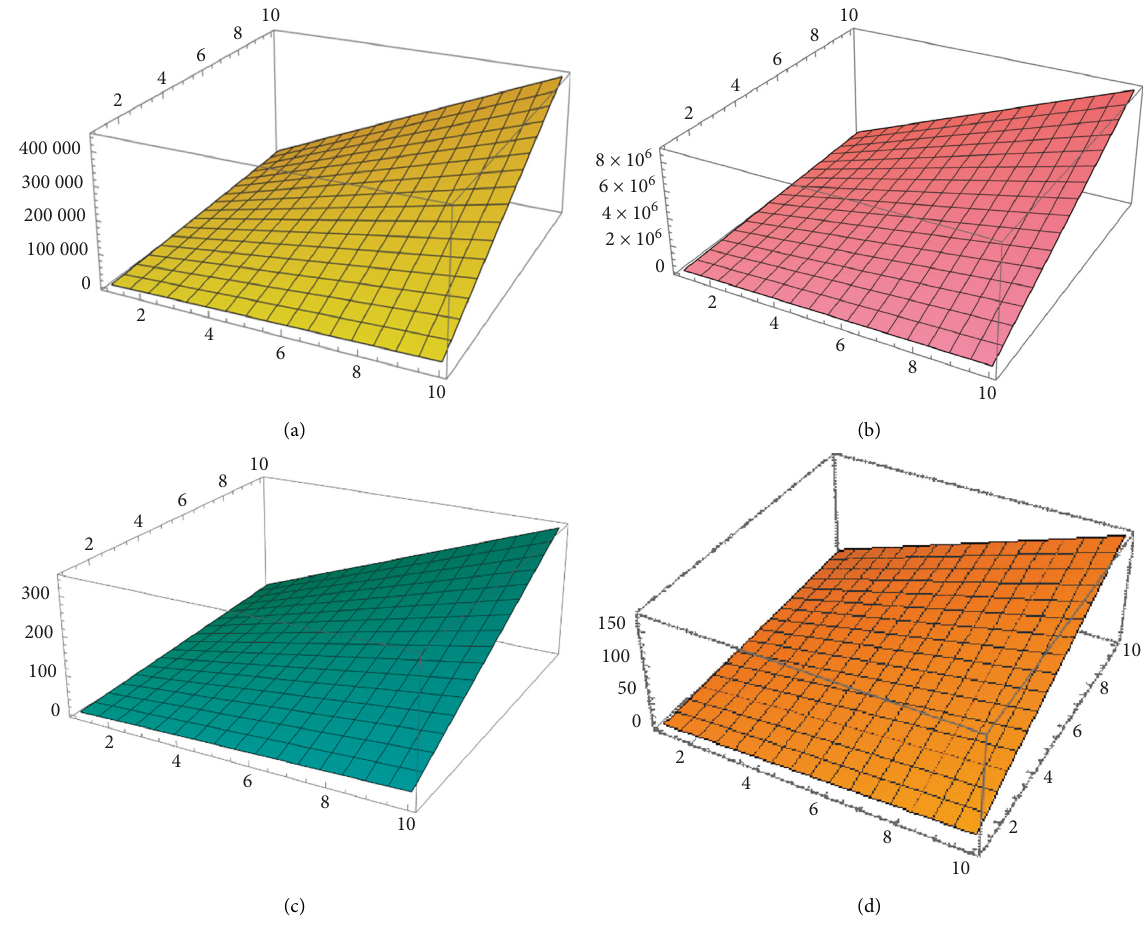
Figure 3: (a) First hyper F-index (HF1) SiC 4 – I [ r, s ]. (b) Second hyper F-index (HF2) SiC 4 – I [ r , s ]. (c) S-connectivity F-index SiC 4 – I [ r, s ]. (d) P-connectivity F-index SiC 4 – I [ r, s